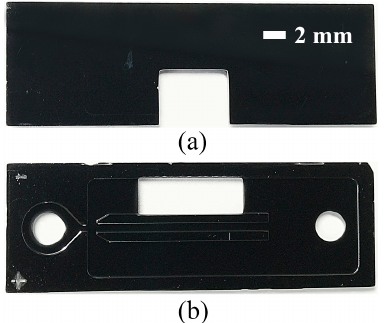
Figure 11. Photograph of a fabricated air current microchannel: ( a ) the upper shell; ( b ) the lower shell.